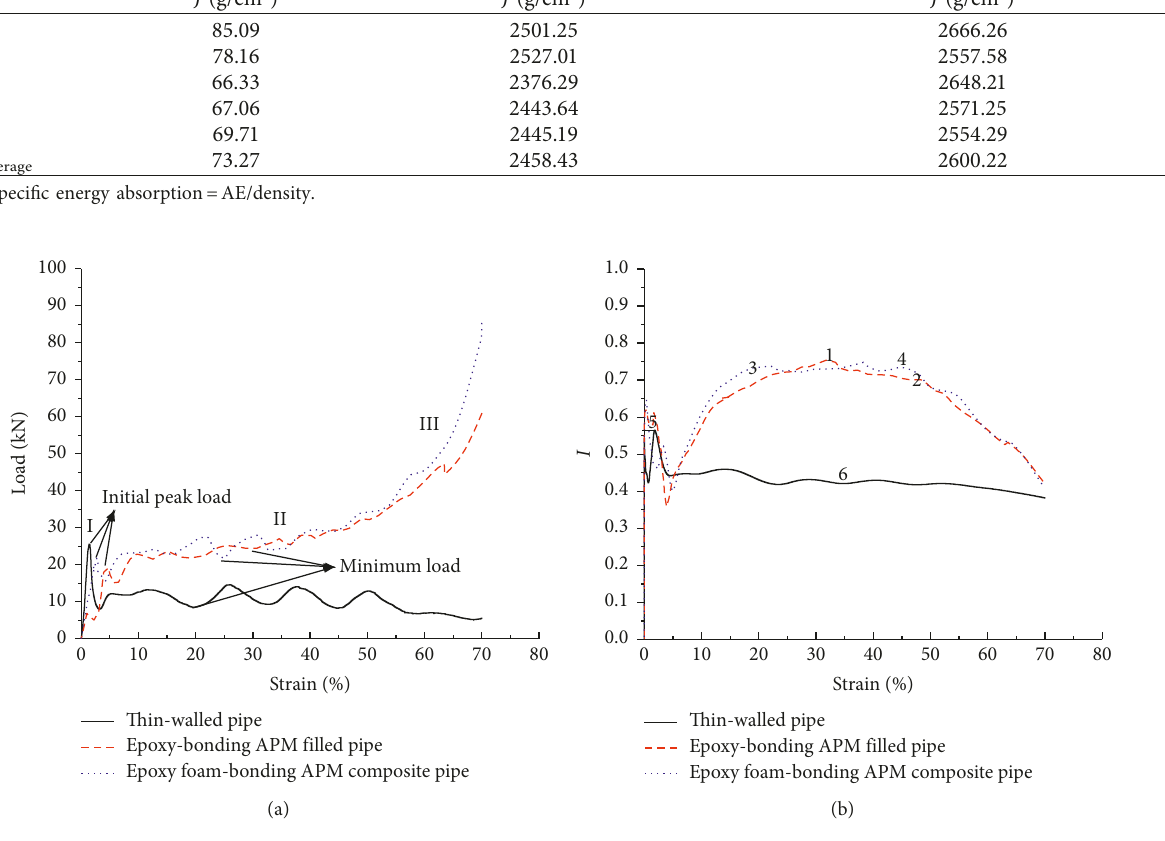
Figure 11: (a) Load-strain curves of three pipe specimens and (b) average quasistatic ideal energy absorption efficiency curves of three pipe